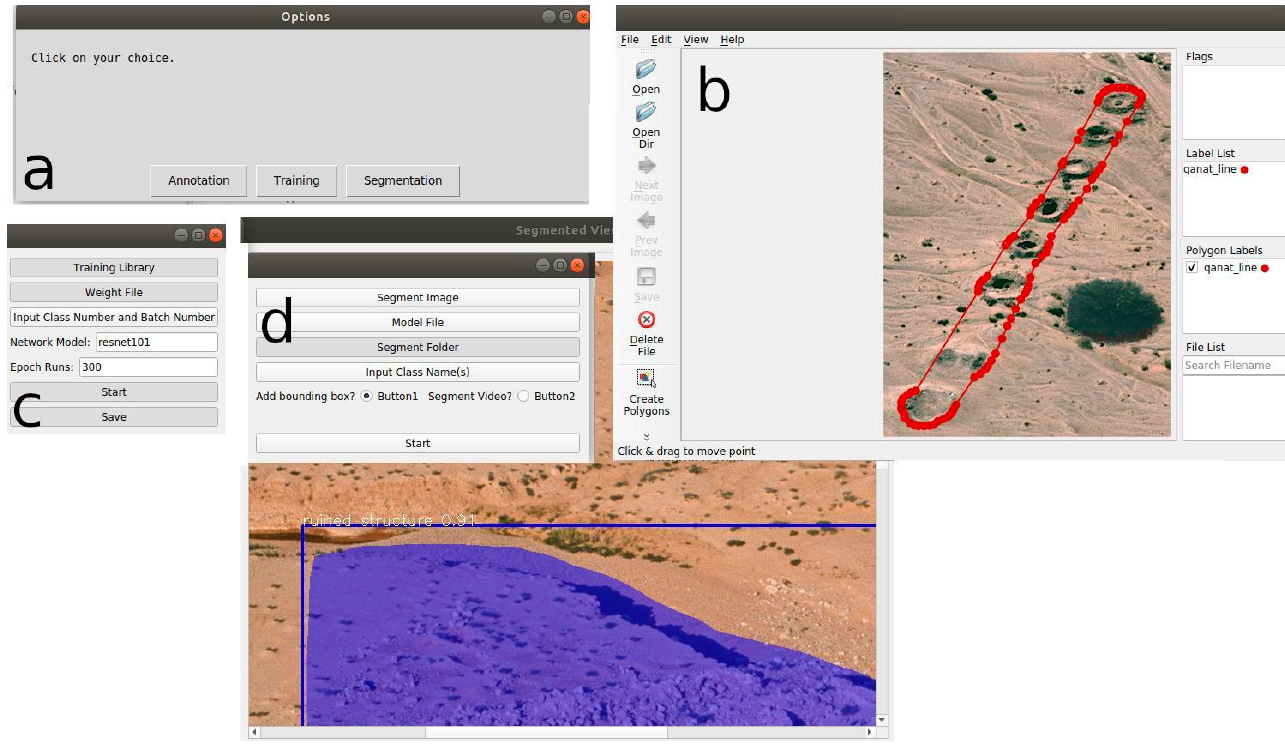
Figure 1. Controller module ( a ) showing options when selecting annotation ( b ), training ( c ), and segmentation ( d ).